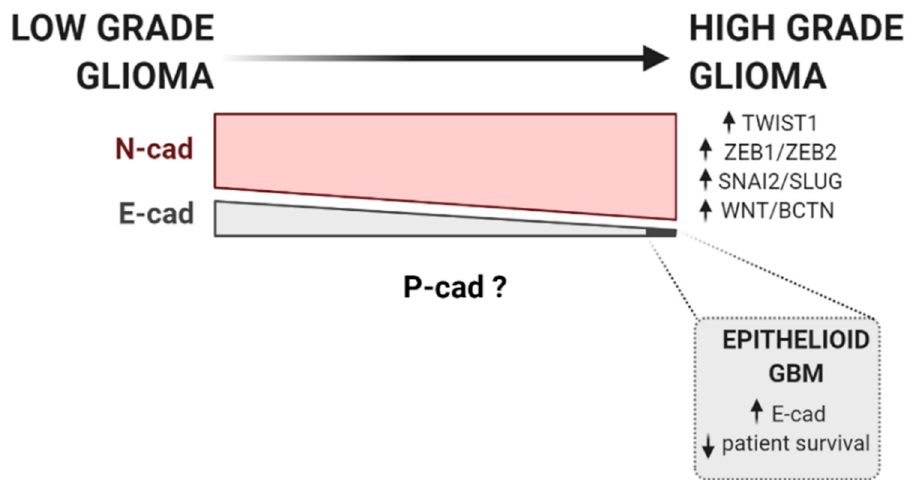
Figure 1. Cadherins and EMT factors expression during glioma progression. The progression of low-grade to high-grade glioma is commonly accompanied by an increase in the activity of classical EMT transcription factors and other well-described EMT-promoting pathways, such as ZEB1/ZEB2 [140,160,161], TWIST1 [164,165], WNT/ β -catenin pathway [167], and SNAI2/SLUG [159,169]. According to current data available, N-cadherin is generally expressed in low-grade glioma, but its expression has been described to be increased in high-grade gliomas [130,141]. On the contrary, E-cadherin is fairly absent in gliomas. Still, its expression is more frequent in low-grade gliomas than in glioblastoma [144,145]. Notwithstanding, in aggressive glioblastoma subtypes, with epithelial and pseudo-epithelial differentiation, E-cadherin is found to be overexpressed [148]. Upward row represents increased expression, whereas downward row indicates decreased patient survival rate.